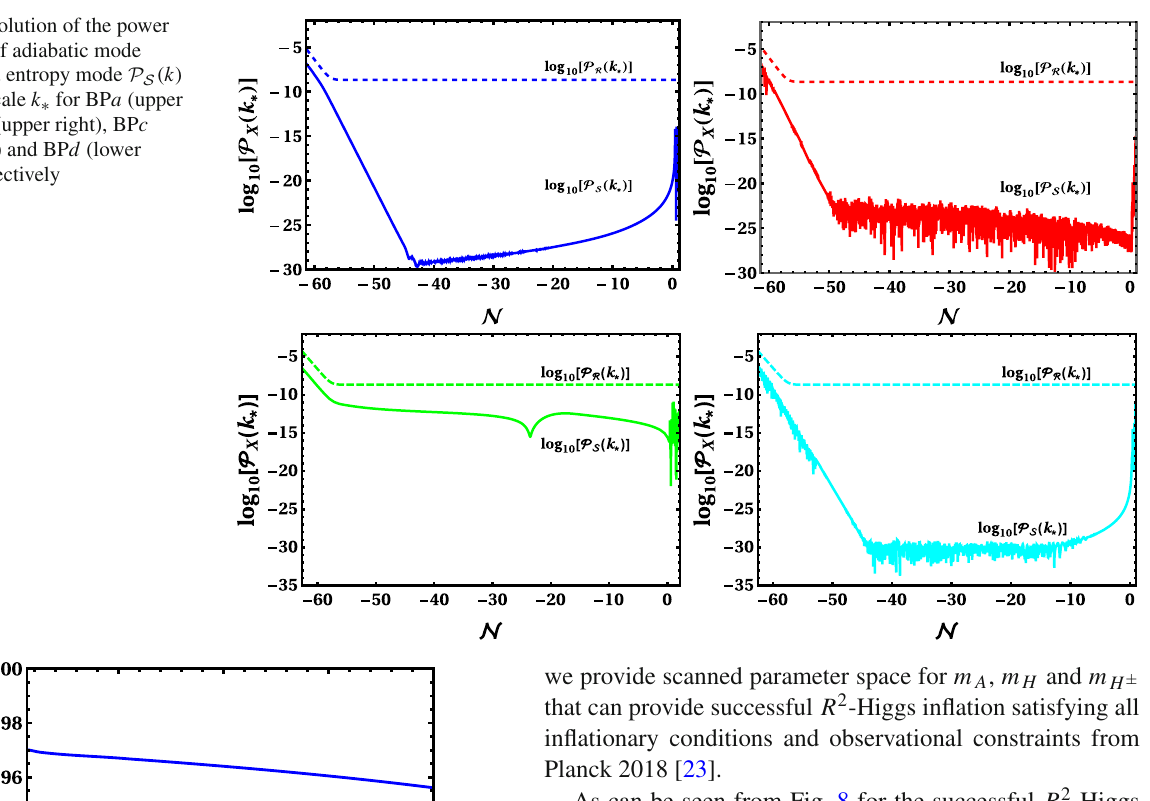
Fig. 6 Evolution of the power spectrum of adiabatic mode P R ( k ) and entropy mode P S ( k ) for pivot scale k ∗ for BP a (upper left), BP b (upper right), BP c (lower left) and BP d (lower right) respectively